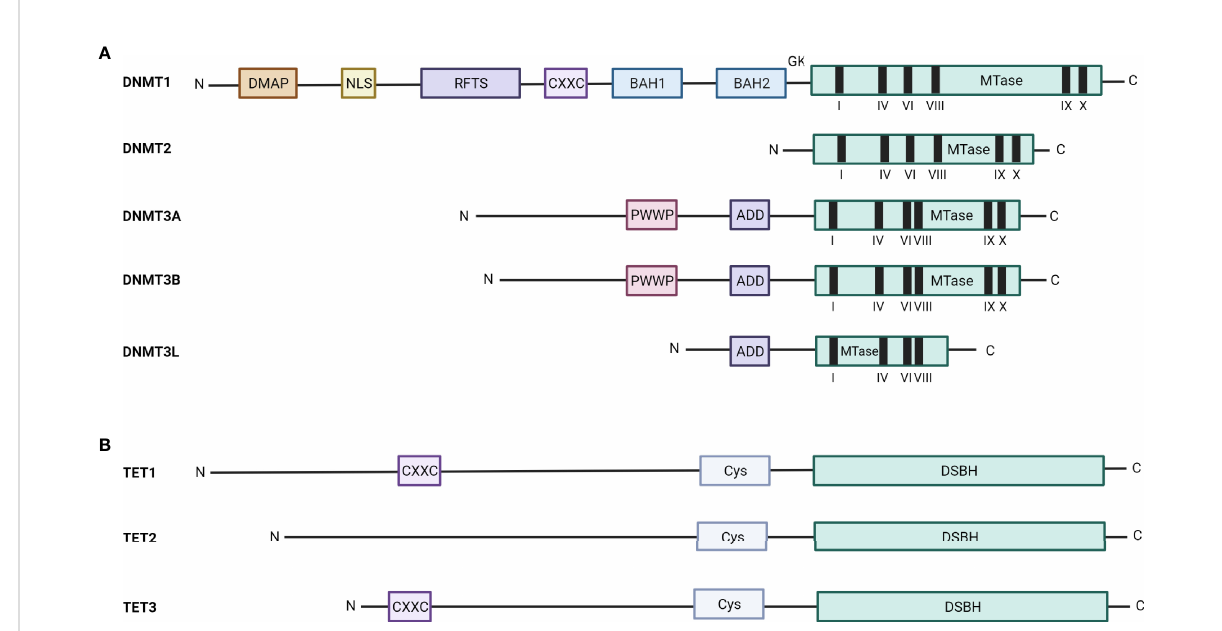
FIGURE 3 Schematic overview of the structure of the DNMT and TET enzymes. The structure and different domains of (A) the fi ve DNMT family members, DNMT1, DNMT2, DNMT3A, DNMT3B, and DNMT3L, and (B) the three TET family members, TET1, TET2, and TET3, are depicted. DMAP, DNA methyltransferase 1-associated protein binding domain; NLS, nuclear localization signal; RFTS, replication foci-targeting sequence; CXXC, Zn fi nger CXXC-domain; BAH, bromo-adjacent homology; GK, glycine-lysine repeat; MTase, methyl transferase; PWWP, proline-tryptophan- tryptophan-proline; ADD, ATRX-DNMT3A/B-DNMT3L; Cys, cysteine-rich domain; DSBH, double-stranded b -helix